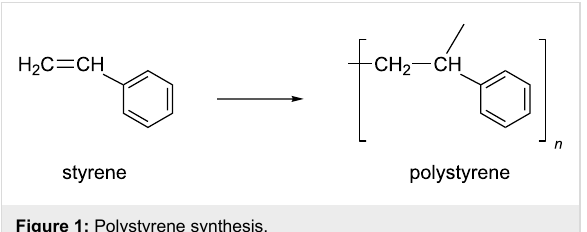
Figure 1: Polystyrene